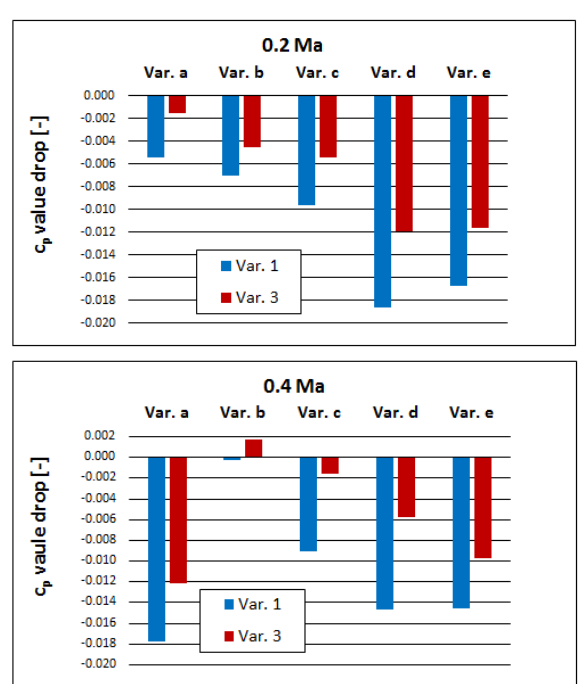
Fig. 20. Influence of individual struts. For illustration the Variant 𝑐 is compared here again (Variant 1 – 0.2 𝑀𝑎 ). The dependence of 𝑐 exhaust hood length is shown in Fig. 21. From the picture, an agreement is evident between experiment measurement results and CFD results.